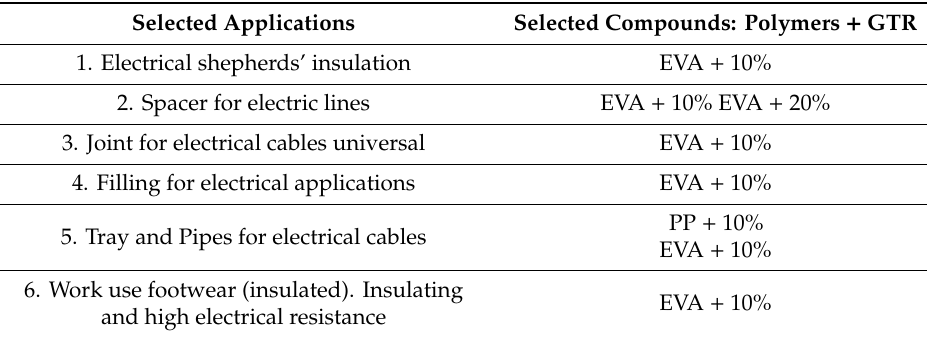
Table 10. Selected compound for each